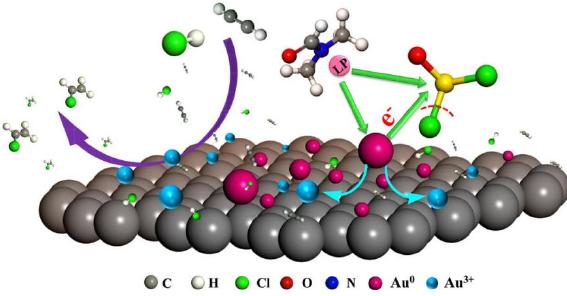
Figure 5. Au catalysts prepared by organic aqua regia [28].